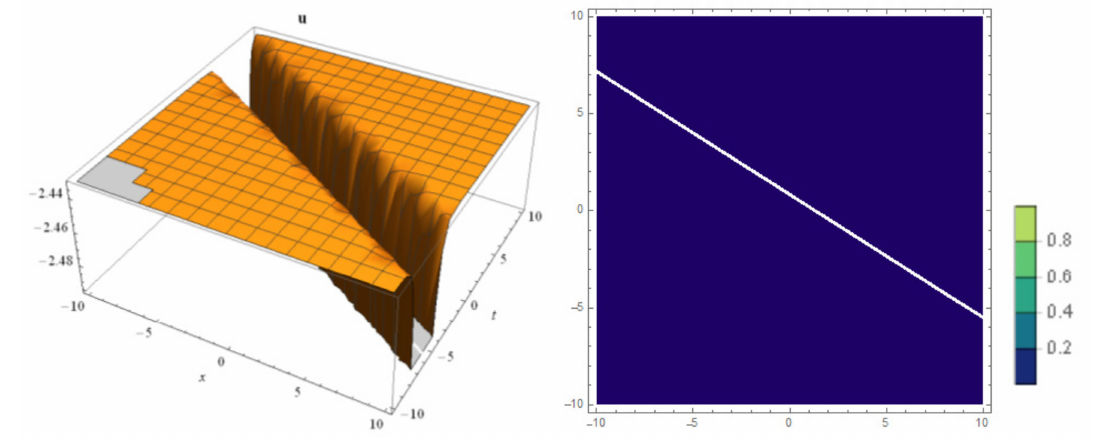
Figure 1. The 3D and contour surfaces of Equation (16) under the values of d = 0.1, α = − 1.8, b = 0.5, ε = 0.4.